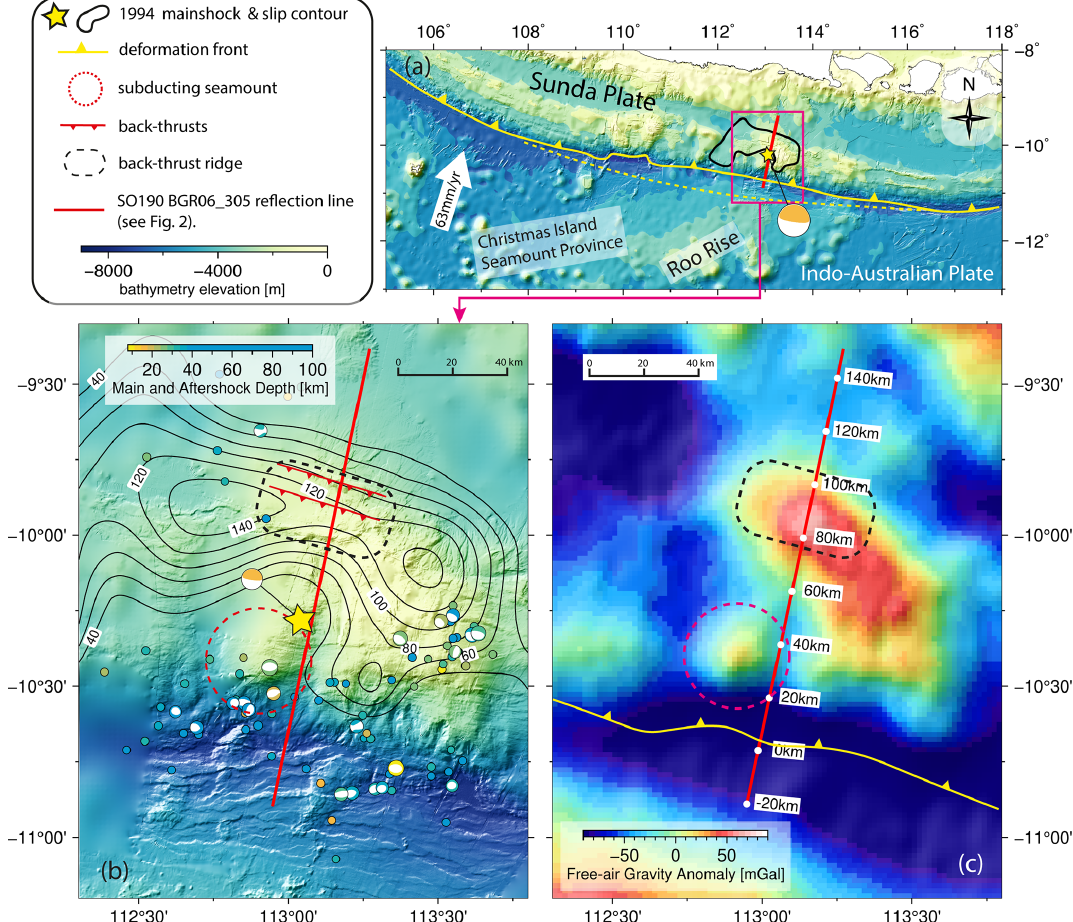
Figure 1. (a) Bathymetric overview, from the General Bathymetric Chart of the Oceans (GEBCO, 2020), of the eastern Java Margin. Yellow line: deformation front. Dashed yellow line: assumed trend of the deformation front prior to frontal erosion related to the Roo Rise (Kopp et al., 2006). Yellow star: 1994 Java Tsunami earthquake epicentre. The moment tensor of the 1994 mainshock (gCMT, Dziewonski et al., 1981; Ekström et al., 2012) is plotted at the position of the 1994 epicentre from the ISC-EHB Bulletin catalogue (Engdahl et al., 2020). Black line: rupture area of the 1994 Java Tsunami earthquake (Bilek and Engdahl, 2007). Red line: Seismic line SO190 BGR06_305 shown in Fig. 2. (b) Local bathymetry acquired during SO190 cruise overlain on the GEBCO_2020 grid. Black lines are slip contours (in cm) of the 1994 Java tsunami earthquake from Bilek and Engdahl (2007). The locations of the mainshock and largest aftershocks (3 June–14 October 1994) are from the ISC-EHB Bulletin catalogue (Engdahl et al., 2020) and focal mechanisms from the gCMT catalogue (Dziewonski et al., 1981; Ekström et al., 2012). The black dashed rectangle and the red triangle markers indicate the back-thrust ridge. The red dashed circle marks the bathymetric elevation associated with the shallow subducting seamount. Note the decrease in co-seismic slip and bending of contour lines around the subducting seamount. (c) Free-air gravity anomaly (Sandwell et al.,